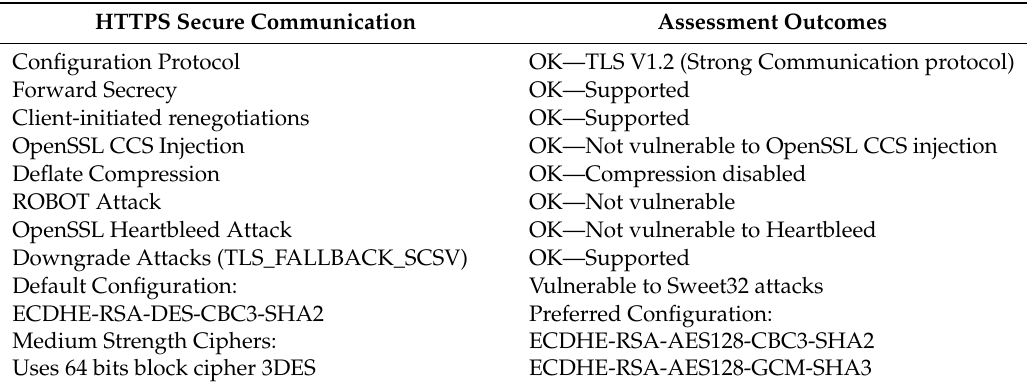
Table 2. HTTPs (hypertext transfer protocol secure) configuration and assessment.